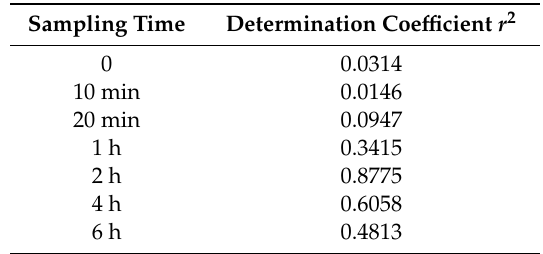
Figure 2. ( a ) Relation between area under the curve (AUC) and HU concentration-time for 2-hour samples; y = 3.5701x + 11.727. ( b ) Relation between AUC and HU concentration-time for 4-hour samples; y = 4.4637x + 28.402. Table 4. Determination coefficient r 2 for the different sampling times.